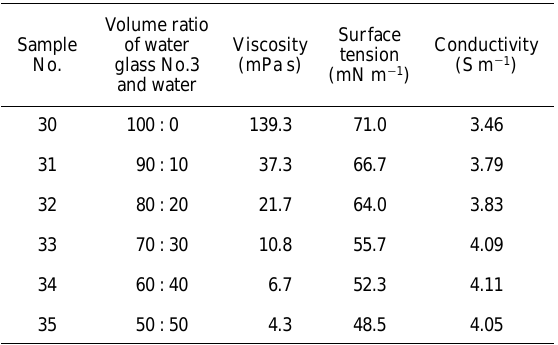
Table 1 Physical Properties of Sample Solutions Measured at 293